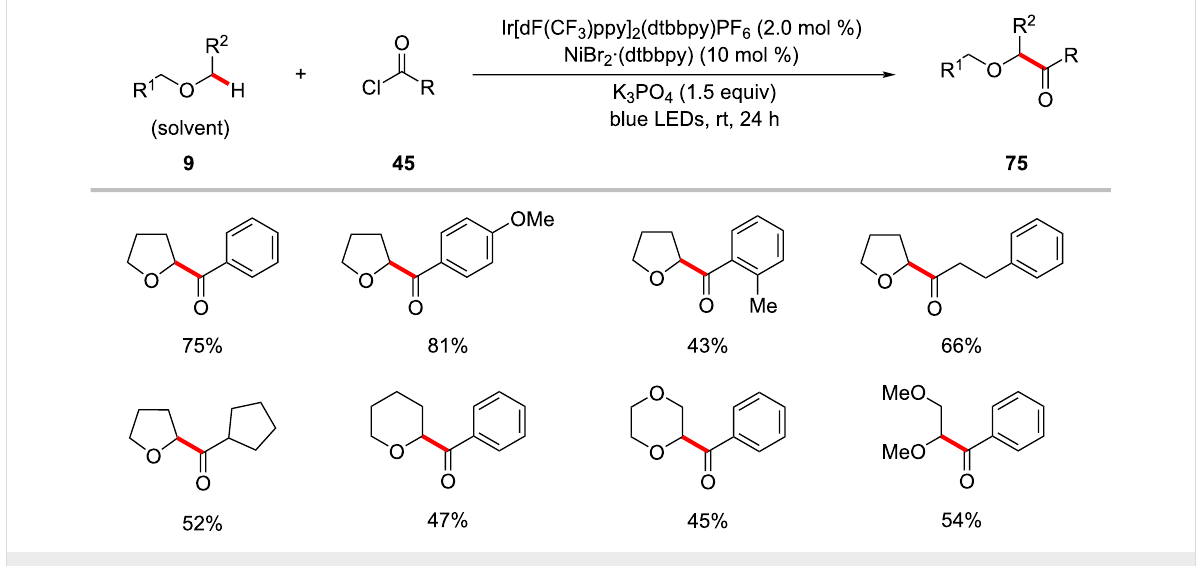
Recently, the group of Huo developed a nickel-catalyzed enan- tioselective acylation of α -amino C(sp 3 )–H bonds with carboxylic acids under visible light irradiation (Scheme 41) [124]. Here, dimethyl dicarbonate (DMDC) was the choice of